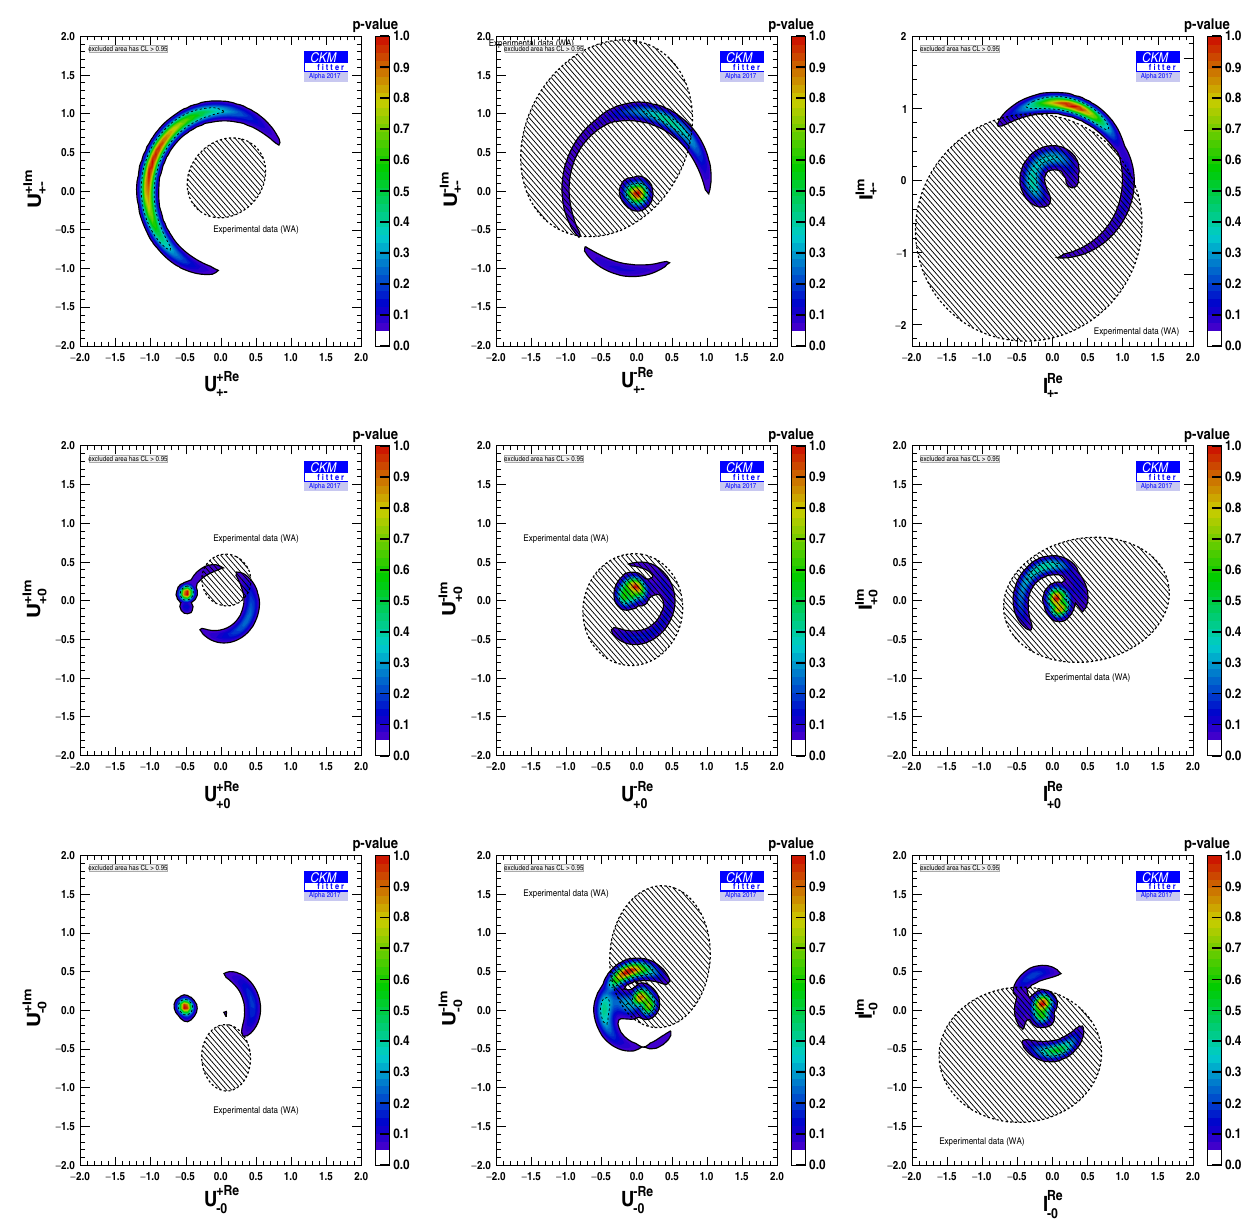
Fig. 32 Two-dimensional SU ( 2 ) isospin constraint on the real and imaginary parts of interference-related coefficients U and I describing the B 0 → π + π − π 0 Dalitz decay. For each observable, the direct mea-